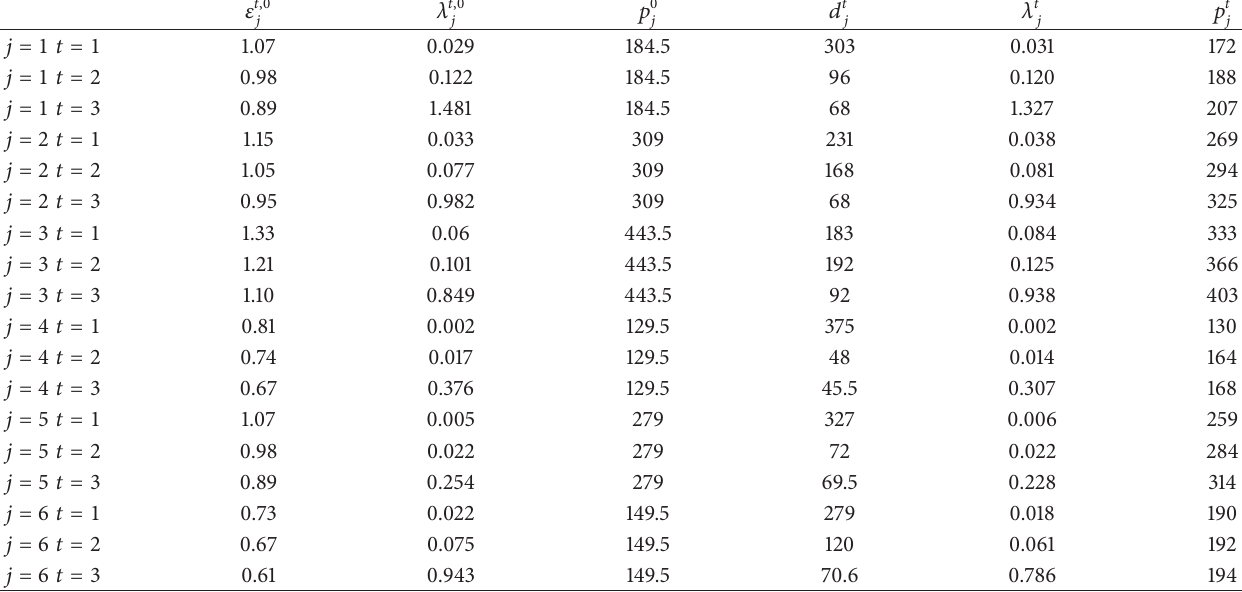
Table 4: Parameters and optimal solution of the three-grade fare